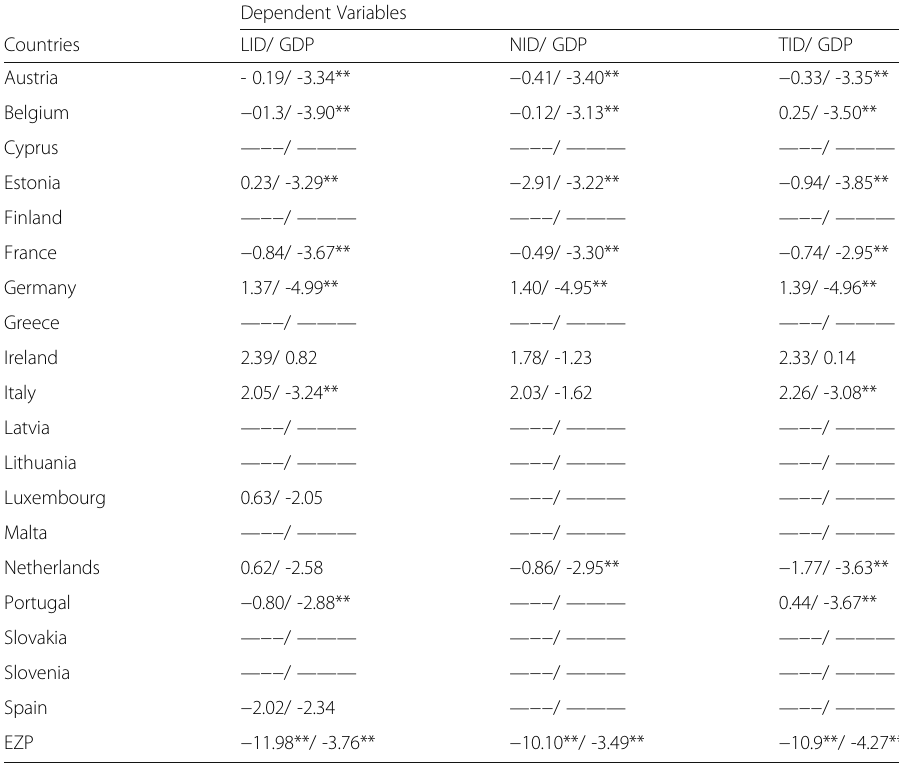
Table 5 Results of Test from the Vector Error Correction Model for Long-Run